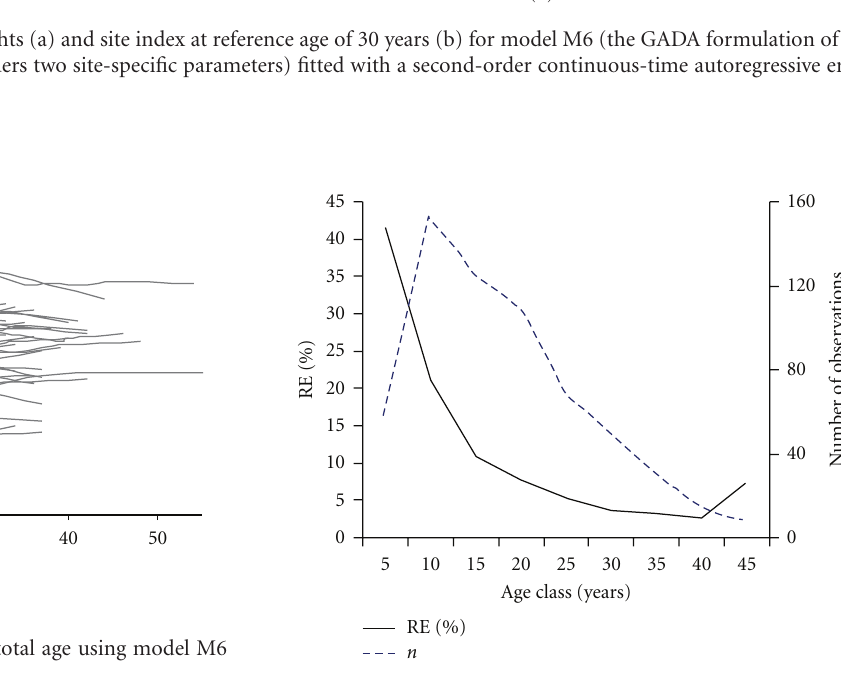
Figure 8: Relative error in height prediction (RE) related to the choice of a reference age for Model (M6) adjusted with CAR(2): RE% by 5-year age classes and corresponding number of observations ( n